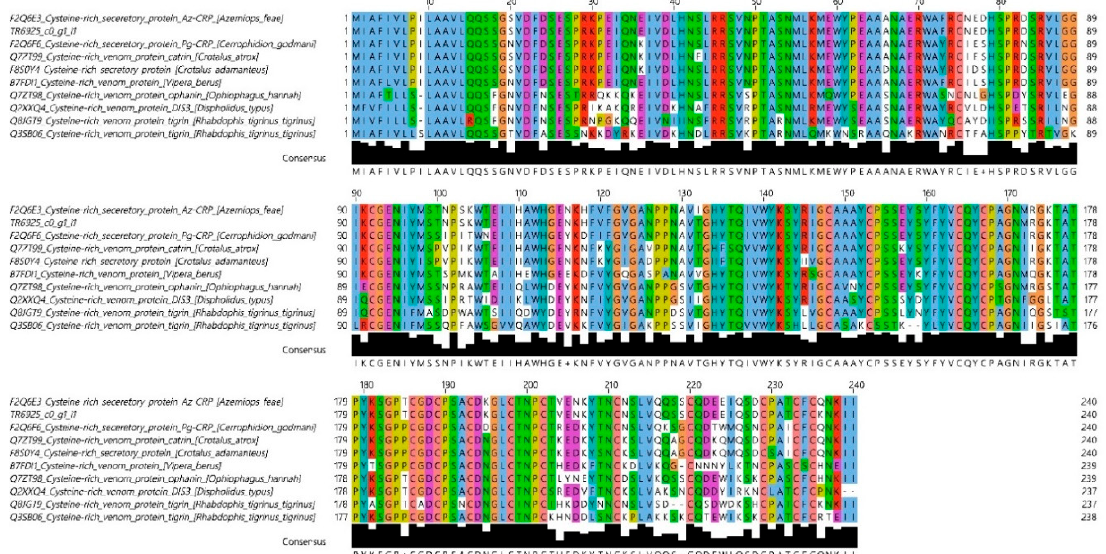
Figure 4. Amino acid sequence of A. feae CRISPs aligned with sequences of homologous proteins. TR6925_c0_g1_i2 is the sequence determined in this work. Alignment was generated by MUSCLE (Here and in all following captions MUSCLE is MUltiple Sequence Comparison by Log-Expectation) with ClustalX Colour Scheme: hydrophobic amino acid residues—blue; positively charged—red; negatively charged—magenta; polar—green; cysteines—pink; glycines—orange; prolines—yellow; aromatic—cyan; unconserved -white.